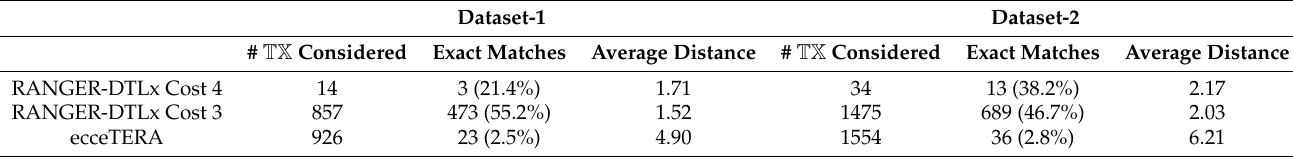
Table 5. Accuracy of placing unsampled species donors on the species tree. All TX events inferred by each method, regardless of support, for which the recipient species was identified correctly were used for this analysis. The inferred unsampled donor is considered an exact match if the location of the donor lineage on the species tree is the same as the true location of the donor. Numbers for TX events considered and exact matches are aggregated across all 500 gene tree/species tree pairs in each dataset. The distance between the inferred and true locations of the donor is defined to be the number of edges between the inferred donor lineage and the true lineage on the full species tree (including extinct lineages) as simulated by Zombi.